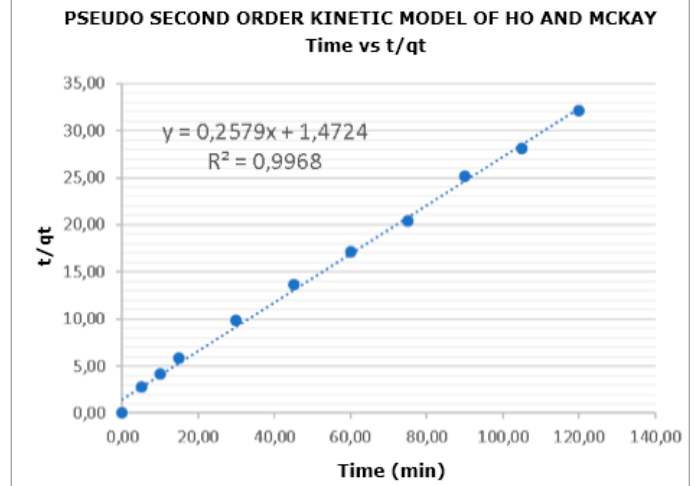
Figure 6. Pseudo second order of Ho and McKay kinetic model for the removal of Cr (VI) with CP.